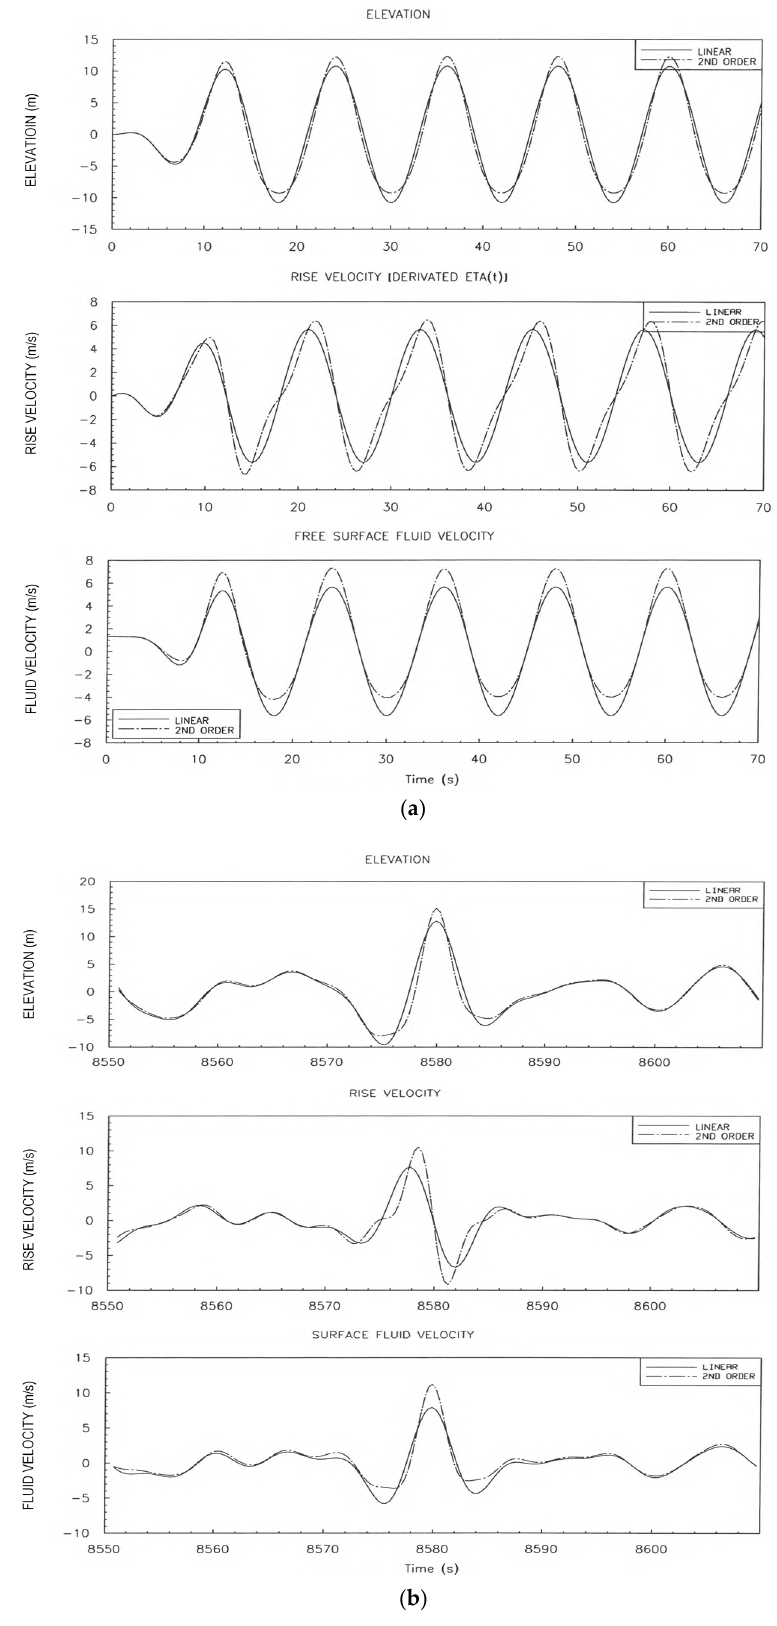
Figure 5. Time series examples of wave elevation, rise velocity, and free-surface horizontal fluid velocity. Numerical linear and second-order wave models: ( a ) steep regular wave; and ( b ) steep irregular wave.